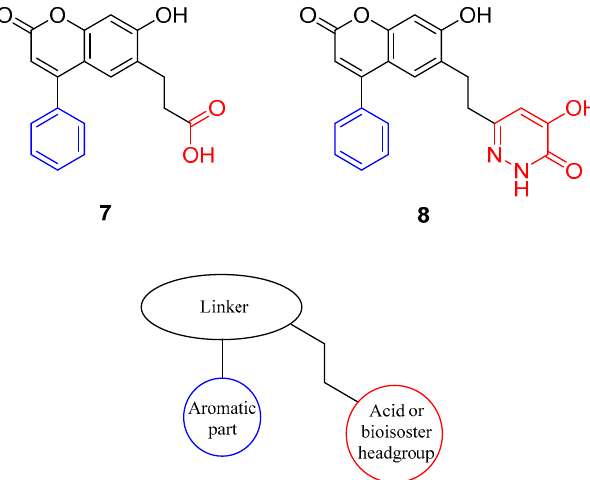
Figure 2. Novel DAAO inhibitors that interact with the flexible loop and the structural moieties of the lid-open type compounds.